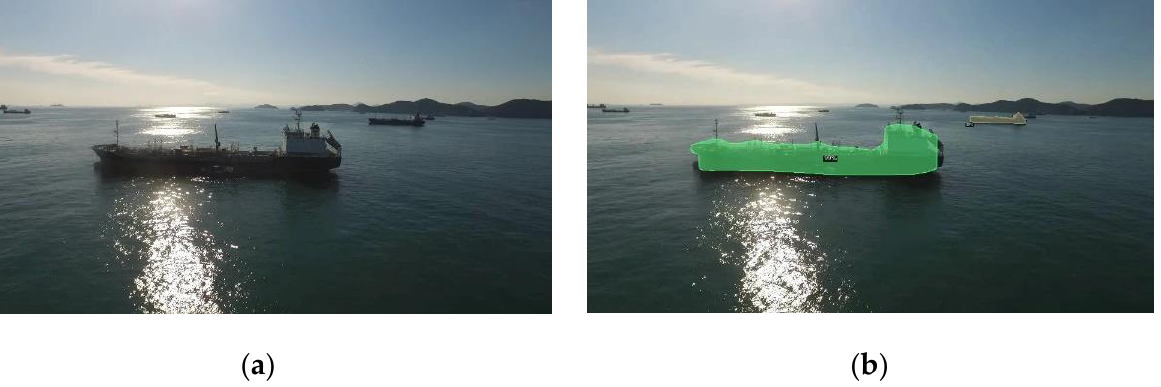
Figure 9. Comparison Result of the Original Video ( a ) and Ship Detection Using the Trained Mask R-CNN Model ( b ) in the Same Frame Screenshot.